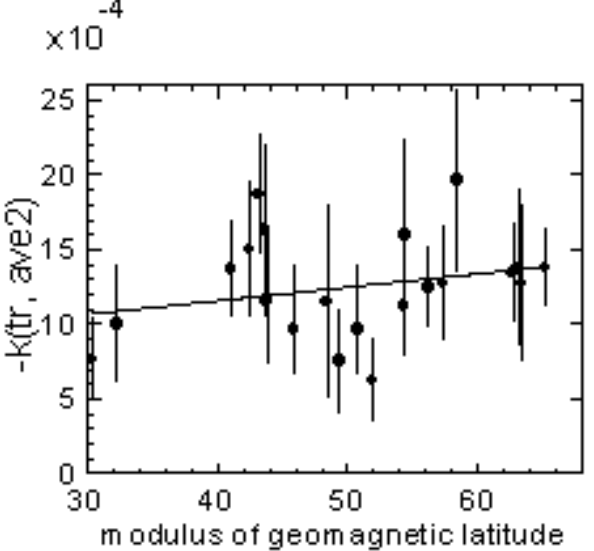
Fig. 3. The nongeomagnetic trends k(tr, ave 2 ) obtained for various stations versus the modulus of the geomagnetic latitude (points). The line represents the regression line through the data points. The bars correspond to the σ (2) values shown in Table 3.